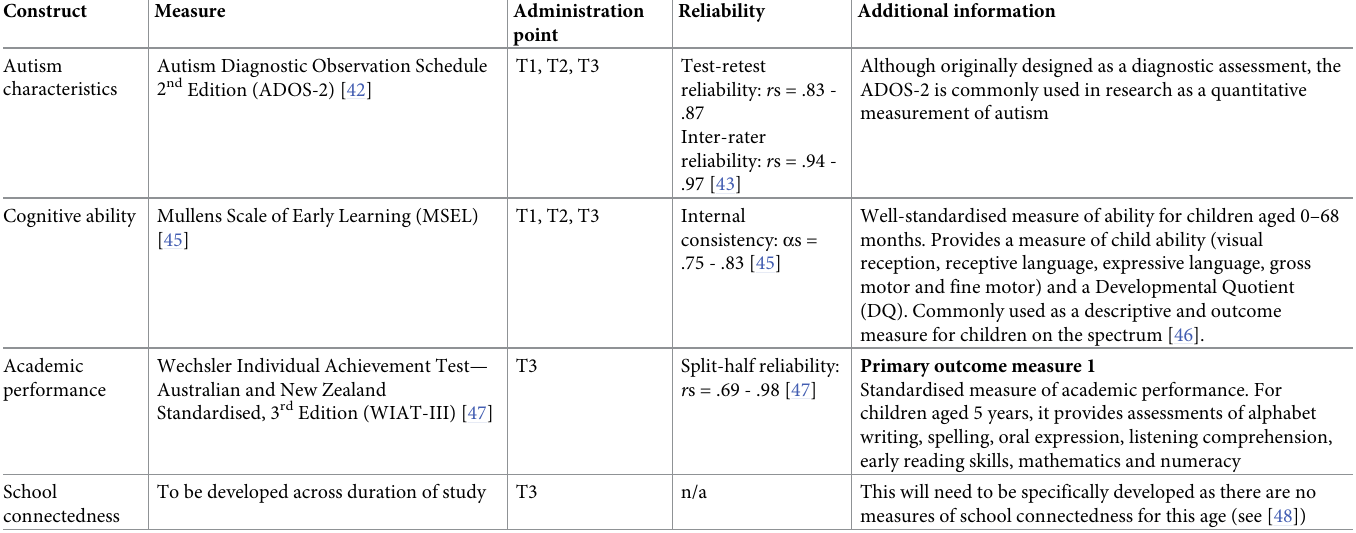
Table 1. Child assessments used in